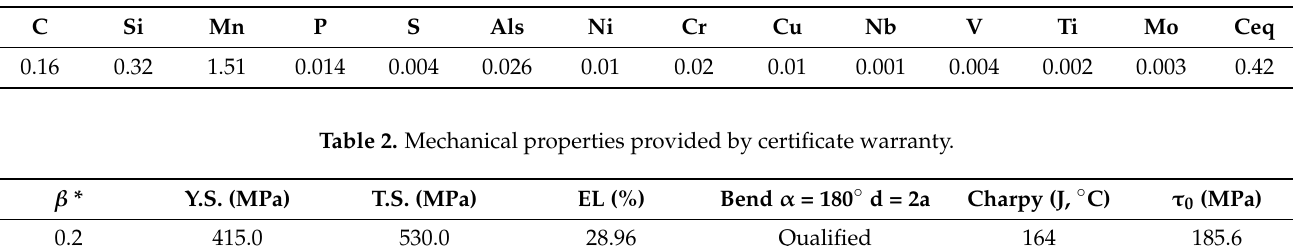
Table 1. Chemical composition of substrate of TC bimetallic steel tested (mass fraction, %).